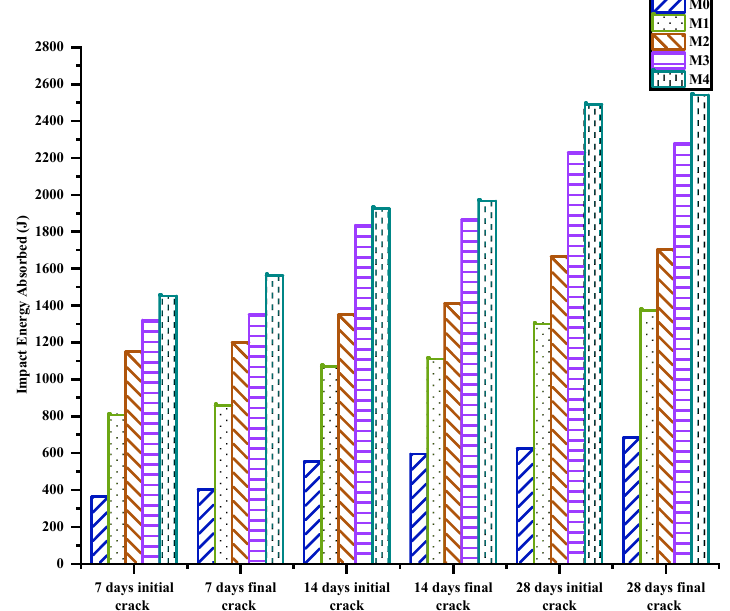
Figure 5. Energy absorption of basalt fiber reinforced fine-grained cementitious composites for five different mixes.